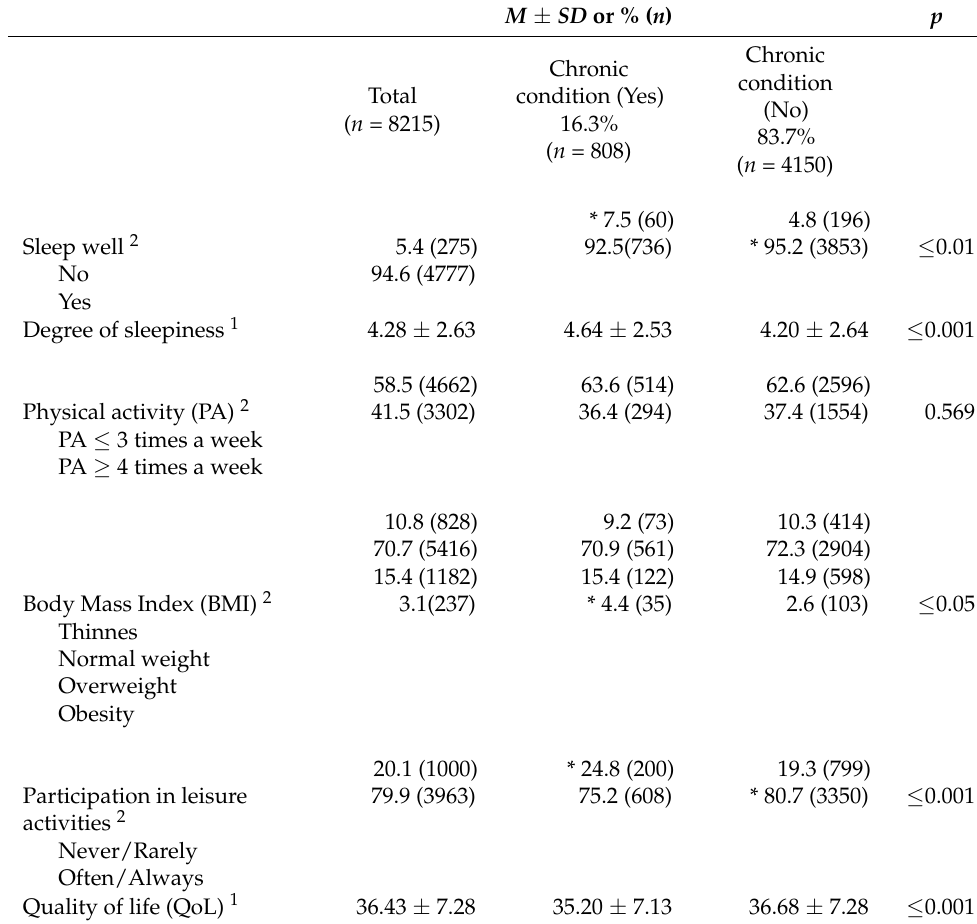
Table 2. Population characteristics and bivariate analysis of differences between adolescents with and without a CC.